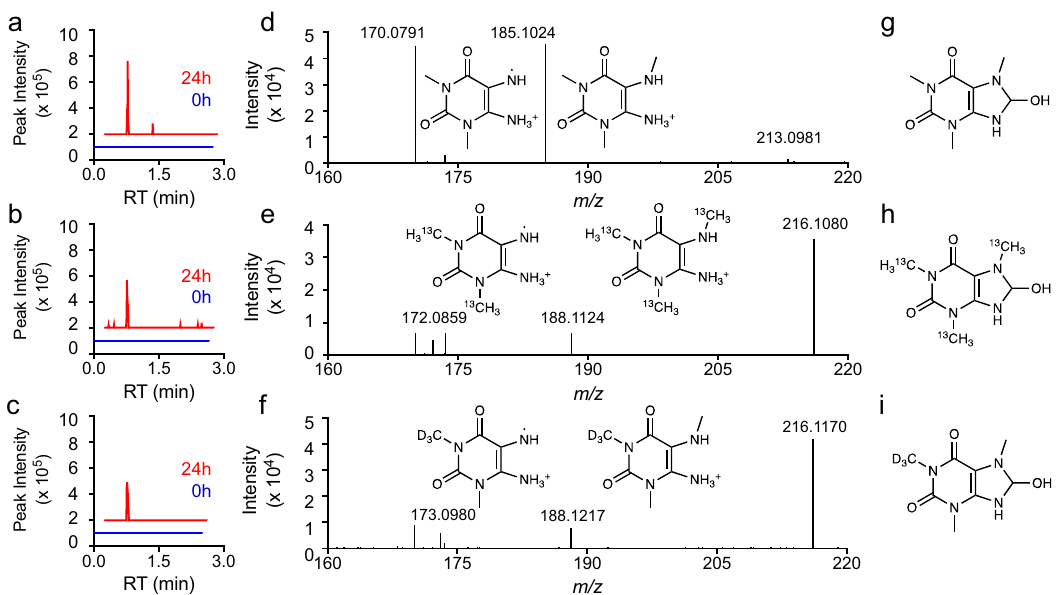
Fig. 4 Stable isotope-assisted unexpected metabolite identi fi cation. a Time-dependent formation of 213.0981 m / z from caffeine. b Time-dependent formation of 216.1080 m / z from 13 C 3 -caffeine. c Time-dependent formation of 216.1170 m / z from d 3 -caffeine. Annotated MS 2 spectra of d 213.0981 m / z , e 216.1080 m / z , f 216.1170 m / z . Fragment interpretations are provided alongside labeled peaks. Proposed structures of unreported caffeine metabolite: g – i 213.0981 m / z , 216.1080 m / z , and 216.1170 m / z .